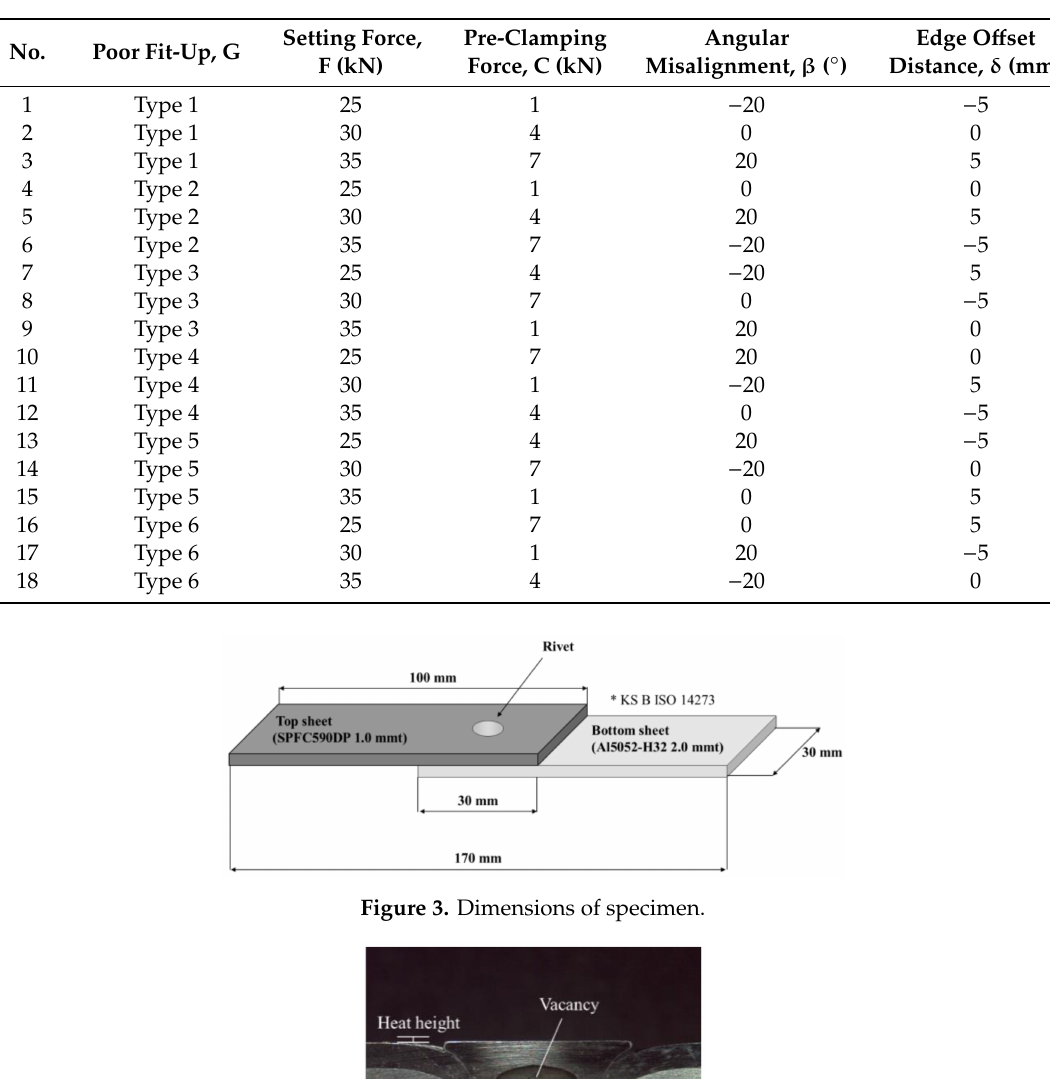
Table 3. Experimental design L18 (6 1 × 3 4 ).